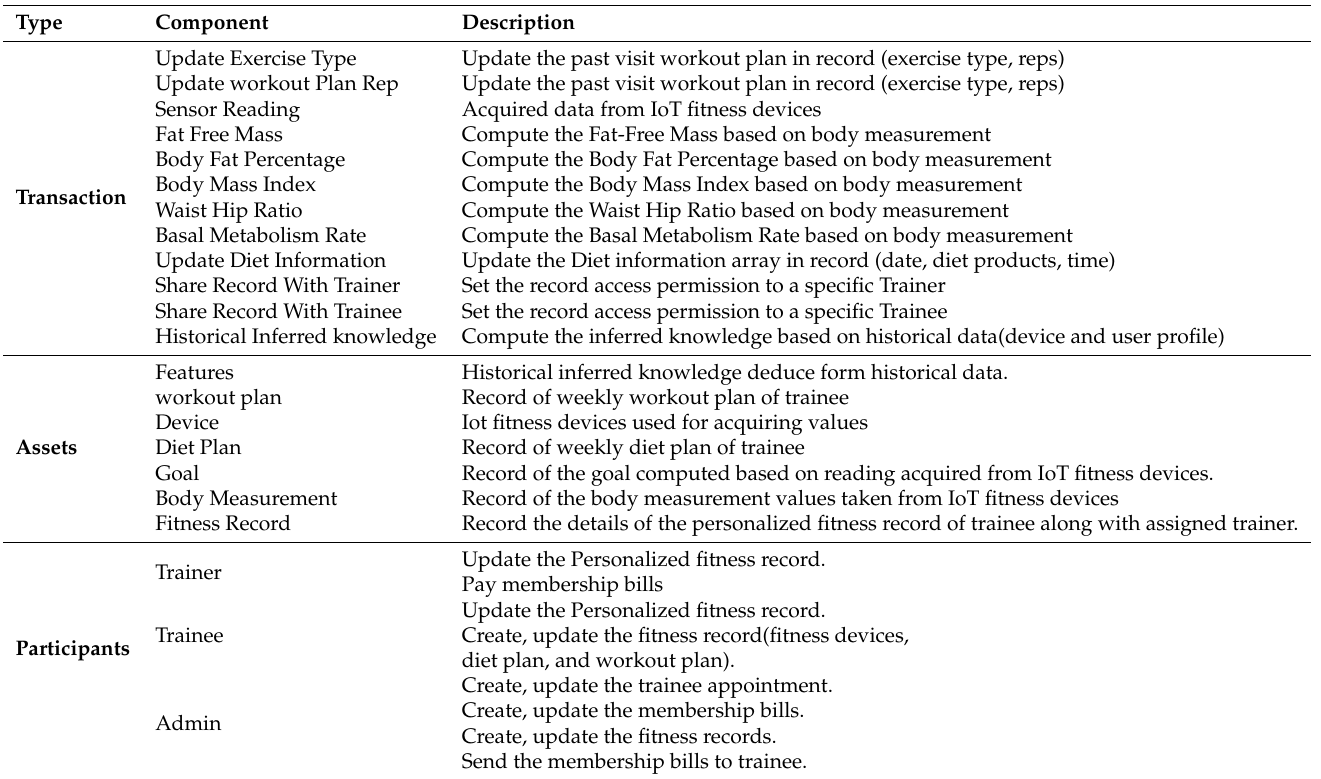
Table 7. Enhanced smart contract modeling for proposed intelligent fitness